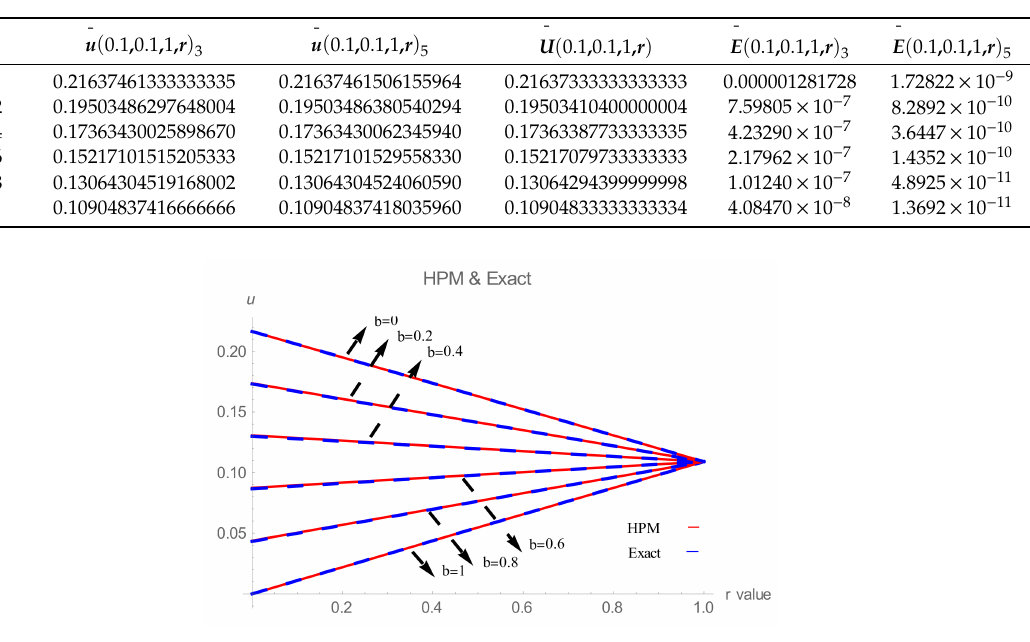
Figure 2. Comparison of the exact and fifth-order double parametric fuzzy HPM solutions of Equation (24) at x , t = 0.1 for di ff erent values of r , b ∈ [ 0,1 ] .